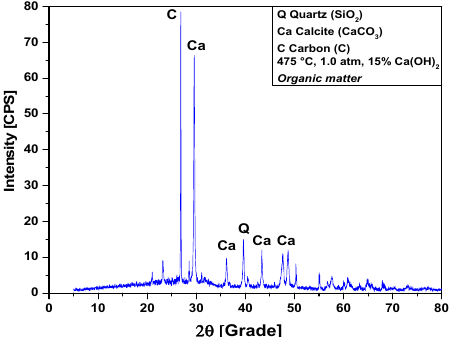
Figure 15. XRD of solid phase products by catalytic cracking of (organic matter + paper) fraction of MHSW at 475 °C, 1.0 atm, with 15.0% (wt.) Ca(OH) 2 , using a borosilicate glass reactor of 125 mL, in laboratory scale.